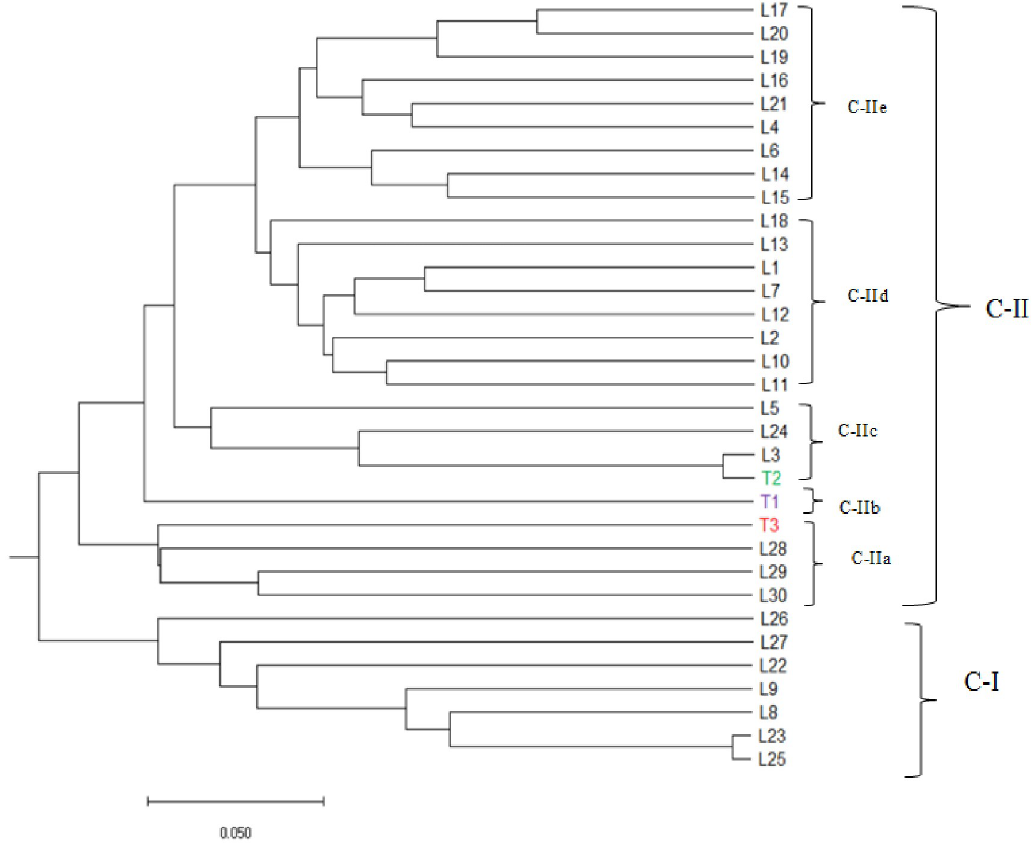
Fig 3. Dendrogram constructed using the Unweighted Pair Group Method Using Arithmetic Averages (UPGMA) clustering method for 30 Striga hermonthica resistant inbred lines and three testers based on Rogers’ genetic distance estimates. Individuals represented in a different colour are testers (Red = Susceptible (T3), Green = Resistant (T2) and Purple = Tolerant testers (T1).